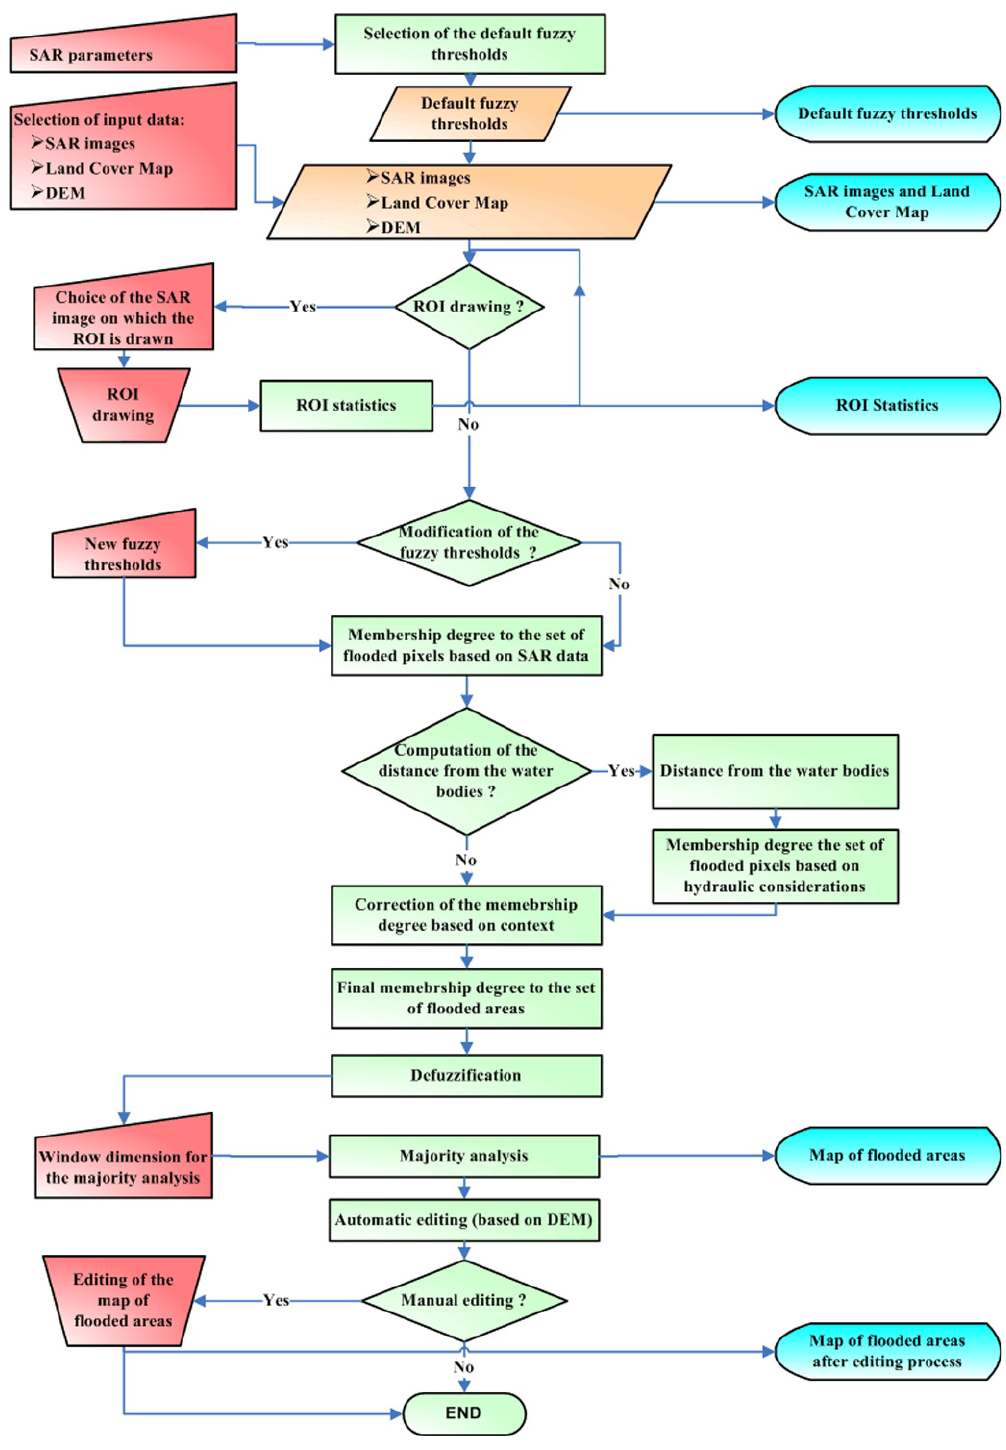
Fig. 2. Flow diagram of the designed algorithm. On the left part of the diagram, the user operations are indicated and represented by red trapeziums (manual inputs) and red isosceles trapeziums (manual operations). On the central part of the diagram, the various steps performed by the algorithm are represented by orange parallelograms (input data reading and storage), green rectangles (processes and operations) and green diamonds (decisions). On the left part of the diagram, the data displayed to the user are indicated (cyan